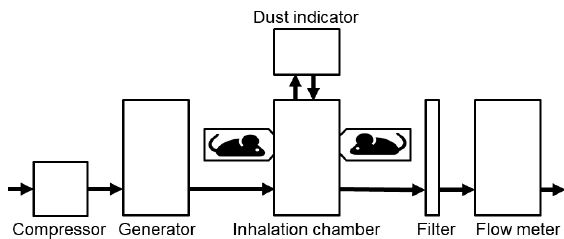
Figure 10. Diagram of the nose inhalation system.